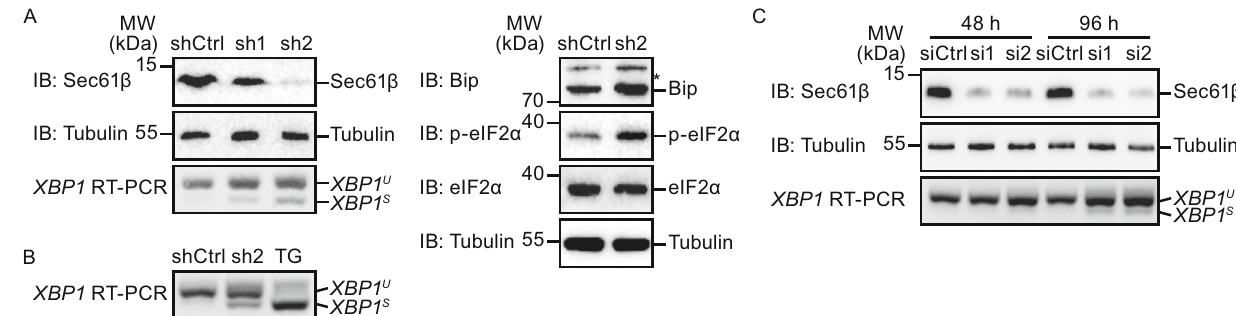
Figure 3. Depletion of Sec61 β triggers ER stress. (A) COS-7 cells were infected with shRNA-expressing viruses. The levels of Sec61 β were determined by Western blotting, and the unspliced (U) XBP1 and spliced (S) XBP1 by RT-PCR of XBP1 mRNA were resolved by agarose gel. ER stress markers, including Bip and phosphorylated eIF2 α , were analyzed by Western blotting. Asterisk (*) indicates a nonspeci fi c band. (B) The unspliced (U) XBP1 and spliced (S) XBP1 by RT-PCR of XBP1 mRNA from infected cells or thapsigargin (TG) treated cells were resolved by agarose gel. (C) U2OS cells were transfected with siRNAs of Sec61 β for 48 h or 96 h. The levels of Sec61 β were determined by Western blotting, and the unspliced XBP1 and spliced XBP1 by RT-PCR of XBP1 mRNA were resolved by agarose gel.